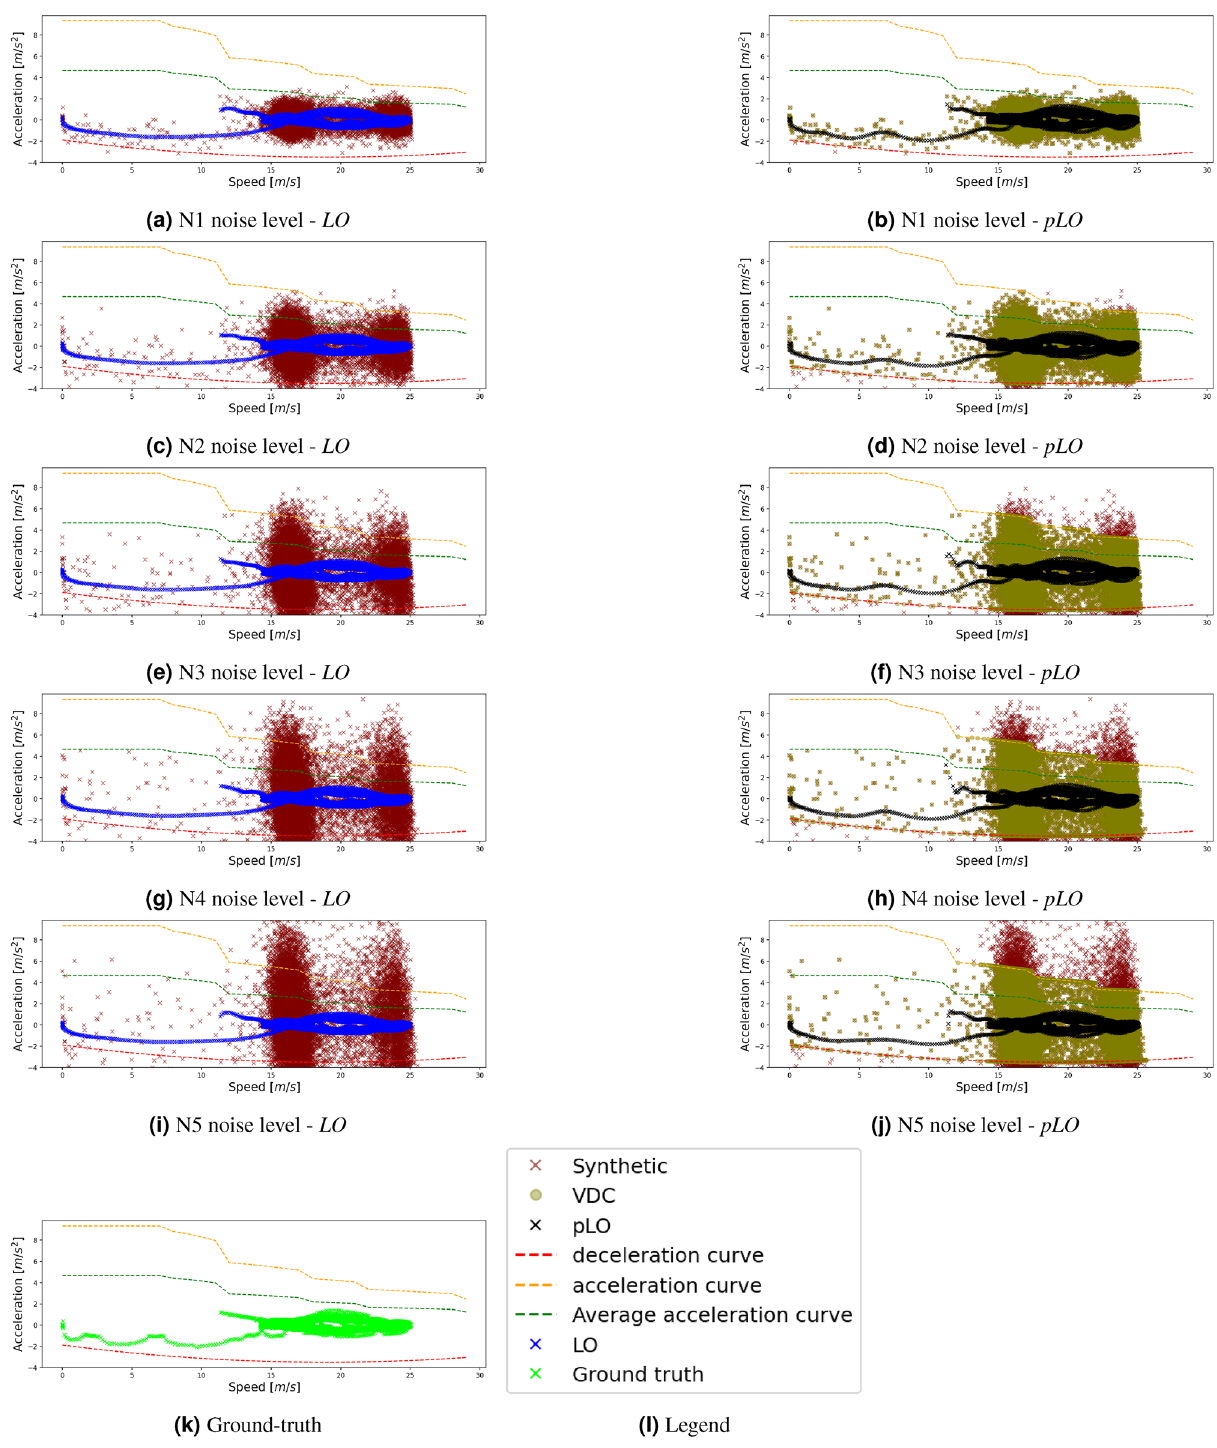
Figure 3. Campaign 1: Comparative results between the Lowess Polynomial Regression with and without the proposed framework for different noise